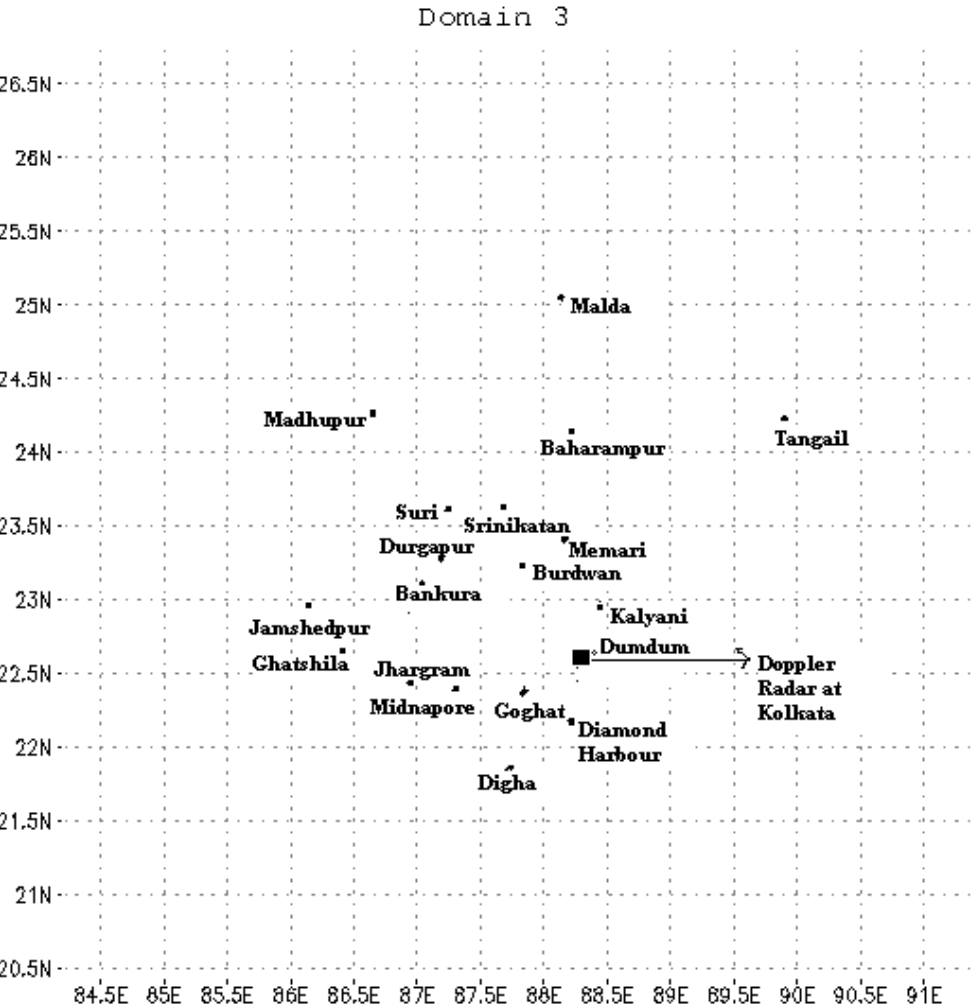
Fig. 3. Various landmarks stated in this work.